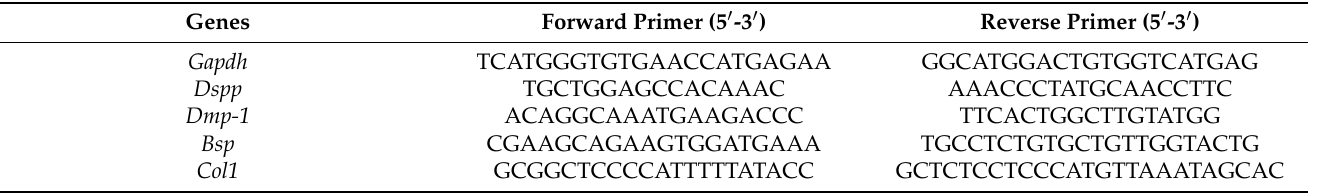
Table 1. Primers for